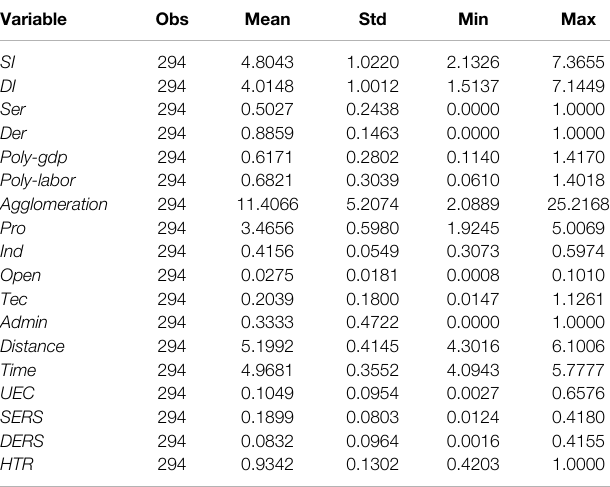
TABLE 2 | The descriptive statistics of city-regions data.